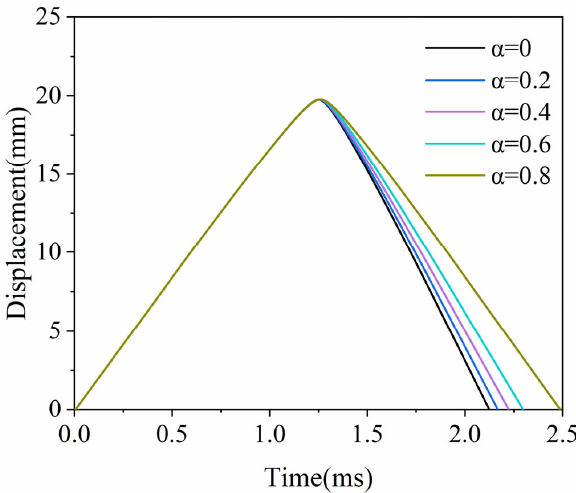
Figure 10. Variation curves of the piston displacement under different α .